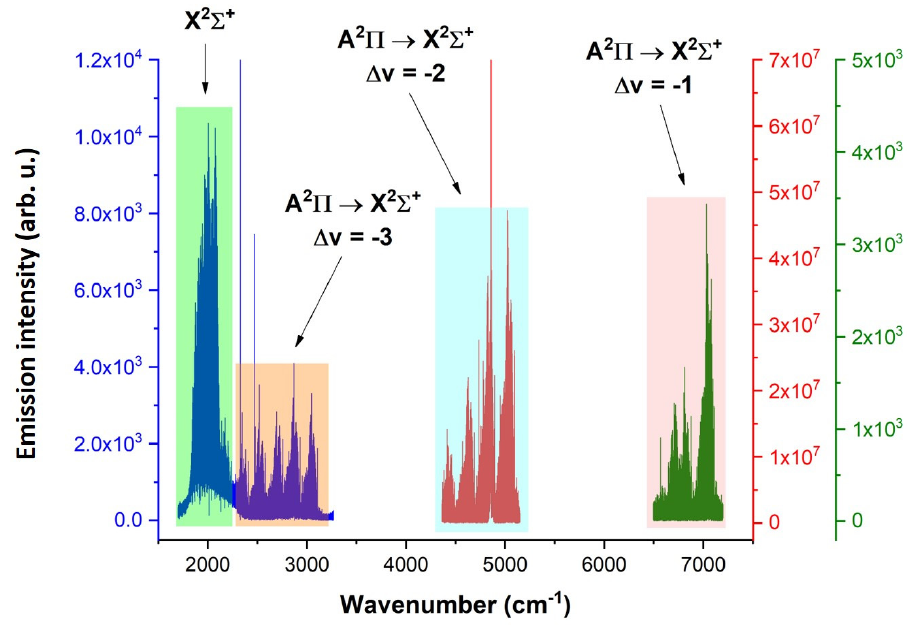
Figure 26. Overall spectrum of all obtained CN bands in the 1800–7500 cm − 1 spectral range.